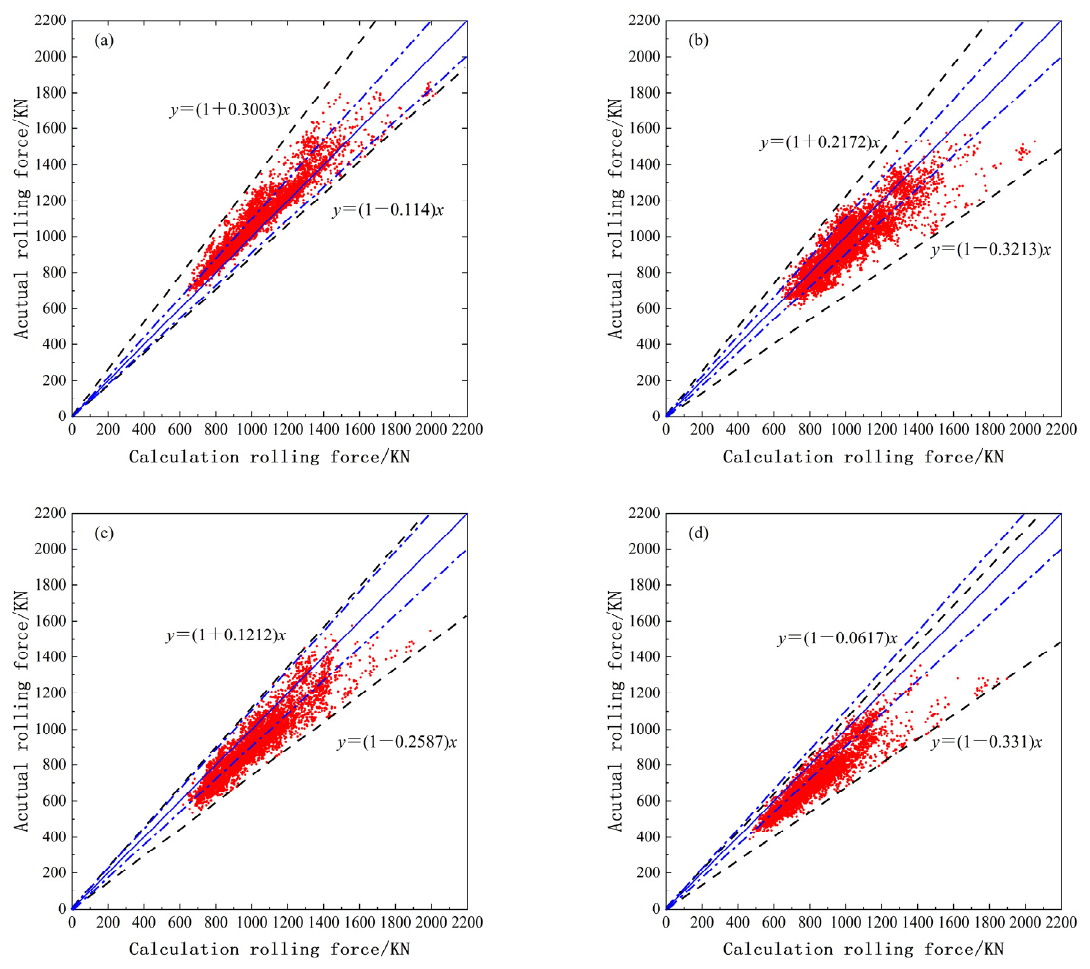
Figure 5. Rolling force calculation results distribution before optimization: ( a ) S1 stand, ( b ) S2 stand, ( c ) S3 stand, ( d ) S4 stand.